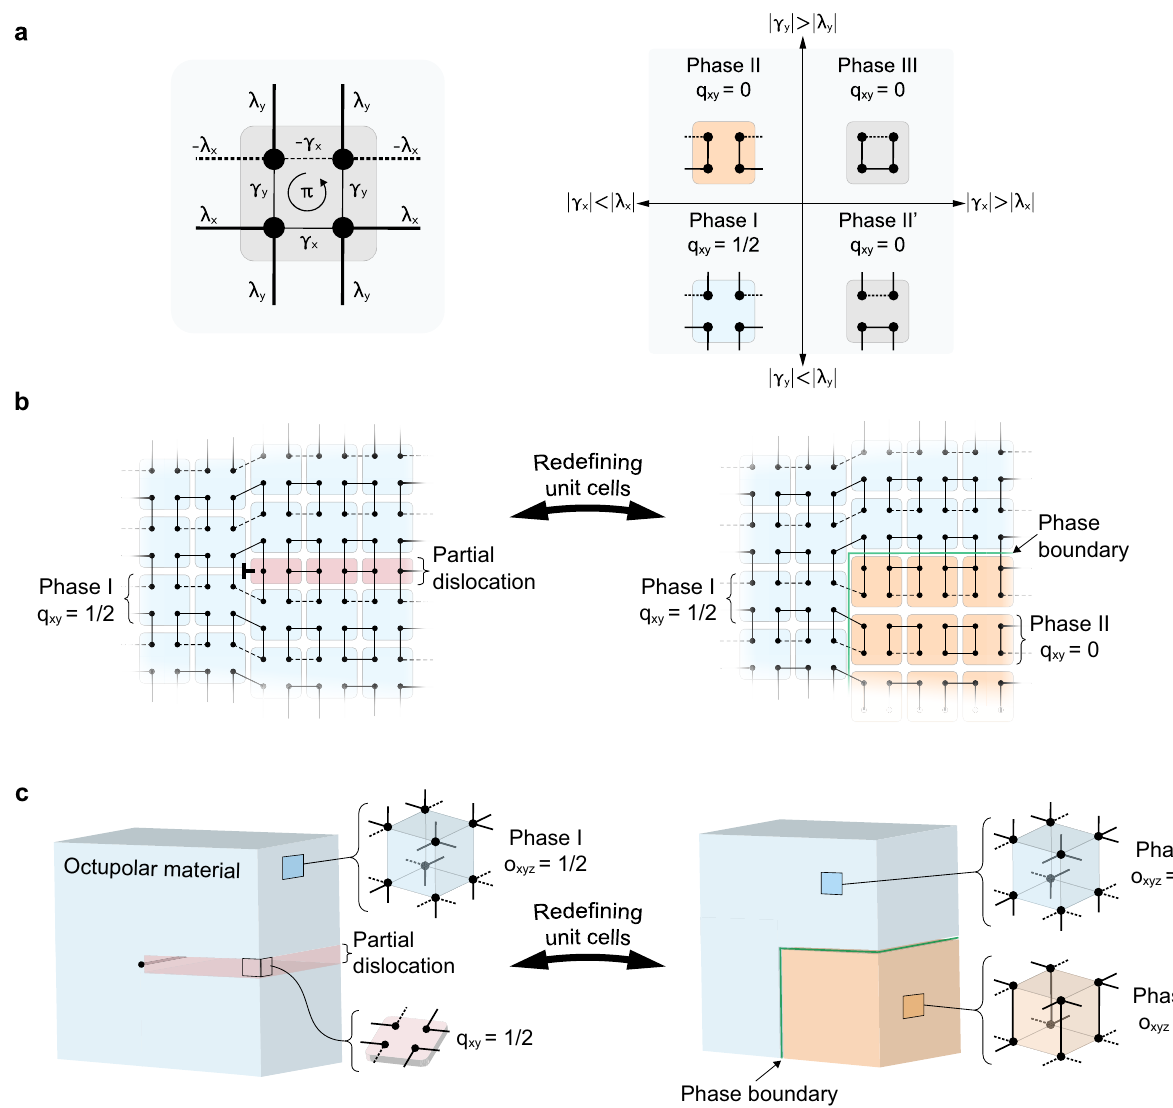
Fig. 1 Origination of topological phase boundaries due to partial dislocations in 2D and 3D multipole HOTI materials. a Possible connections in the minimal model of single quadrupolar TCI unit cell and corresponding topological phase diagram. Intra-cell couplings are labeled as γ x , y and inter-cell couplings are labeled as λ x , y . The dashed lines denote negative coupling. The dimerized limit is illustrated in the phase diagram, so only the dominant connections are shown. b Equivalence between quadrupolar TCI (blue unit cells) in the topological phase with partial dislocation (red unit cells) and phase boundary between trivial (orange unit cells) and nontrivial (blue unit cells) quadrupolar phases. The dislocation core is denoted as ⊢ . The unit cells are depicted in their dimerized limit. c Same as ( b ), but for an octupolar TCI. Here, the partial dislocation is a plane defect and thus terminates along a line within the bulk. The unit cells shown in the inset are depicted in their dimerized